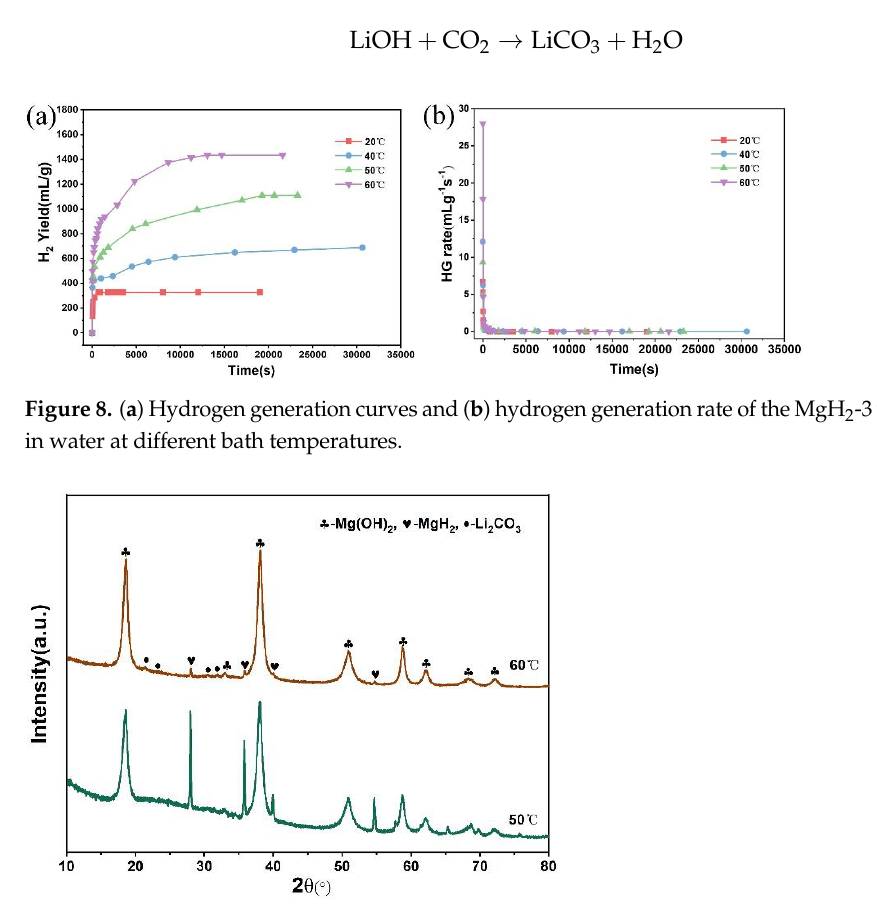
Figure 7. ( a ) SEM of MgH 2 -3 wt % LiH-G and ( b ) MgH 2 -3 wt % LiH-BM.